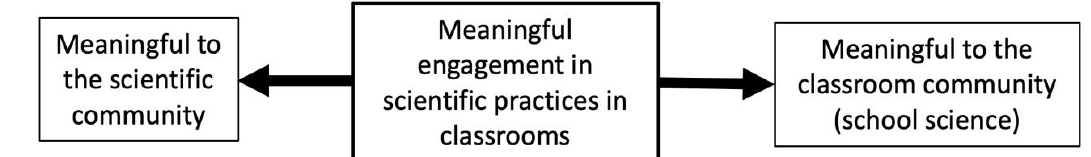
Figure 1. The continuum from Berland et al.: Meaningfulness of the Engagement in Scientific Practices [figure based on Berland et al. (2016)].